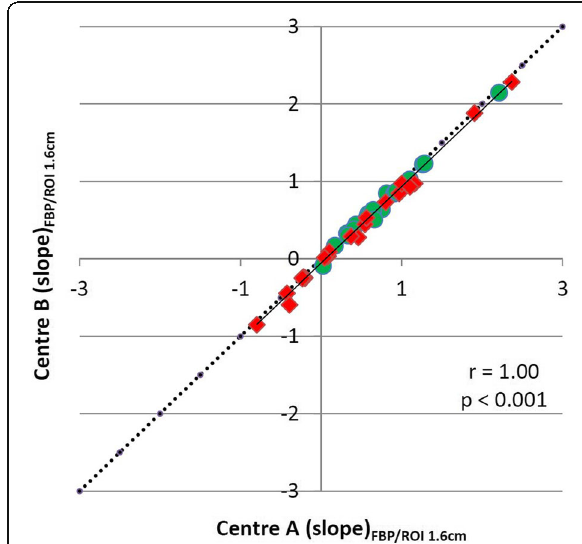
Fig. 7 Correlation of slope of the TAC of 18 F-FET uptake from 10 to 40 min p.i., comparing the effect of different framing in centres A and B. All data were reconstructed by FBP according to centre A and evaluated with a circular ROI with fixed a diameter of 1.6 cm. There is a highly significant correlation which virtually excludes an influence of different data framing. High-grade tumours are indi- cated by red symbols and low-grade tumour by green